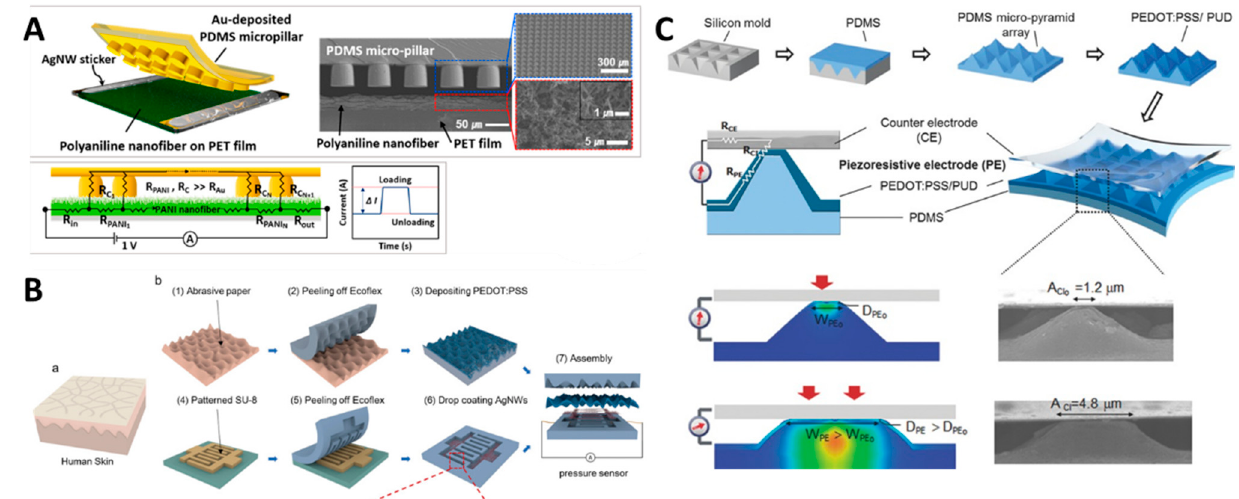
Figure 4. Different types of nanostructures employed to increase the sensor sensibility. ( A ). Au- deposited PDMS micropillars on conductive PANI nanofibers on PET based sensor. (Reproduced from Ref. [70] Copyright © 2015 American Chemical Society); ( B ). Bionic hierarchical structure transferred from abrasive paper based sensor (A-schematic of skin history, B-fabrication process of the sensor), (Reproduced from Ref. [83] Copyright © 2019 WILEY-VCH Verlag GmbH & Co. KGaA, Weinheim); ( C ). PEDOT:PSS/PUD thin film coating PDMS pyramid surface (Reproduced from Ref. [82] Copyright © 2014 WILEY-VCH Verlag GmbH & Co. KGaA, Weinheim).